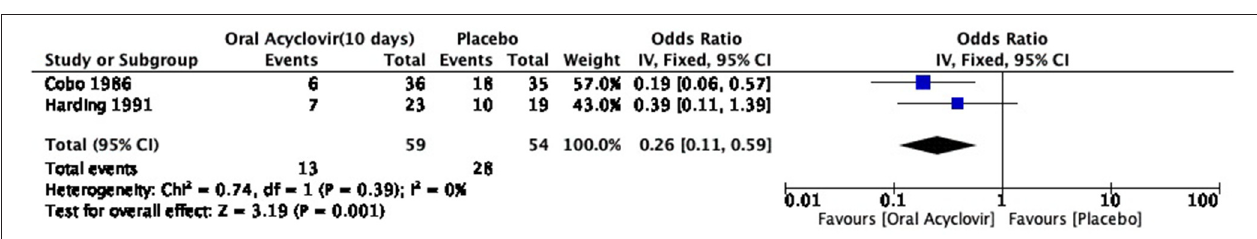
FIGURE 5 | Forest plot comparing treatment failure in herpes zoster ophthalmicus patients developing anterior uveitis treated with oral acyclovir vs. placebo.